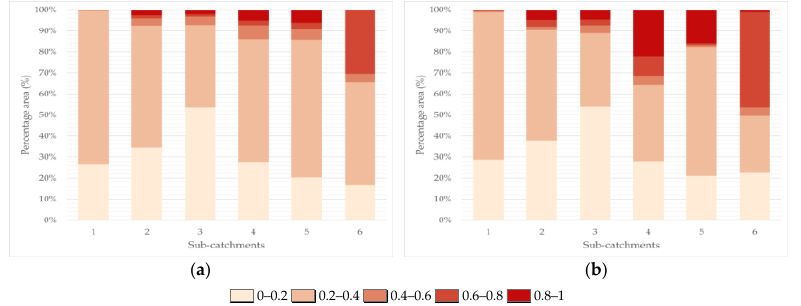
Figure 8. Percentage of area in sub-catchments 1–6 falling within the different land cover indicator (LCI) classes in ( a ) 1997 and ( b ) 2017.